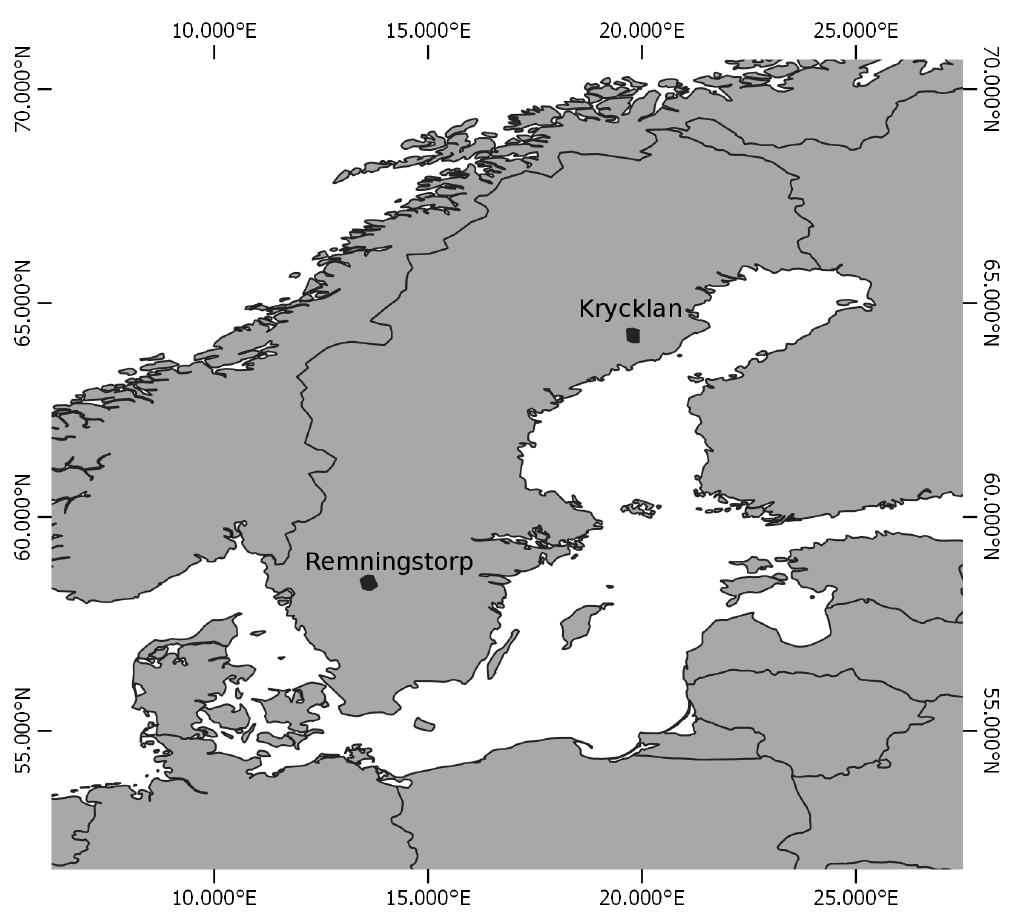
Figure 1. Location of the Remningstorp and Krycklan study areas in